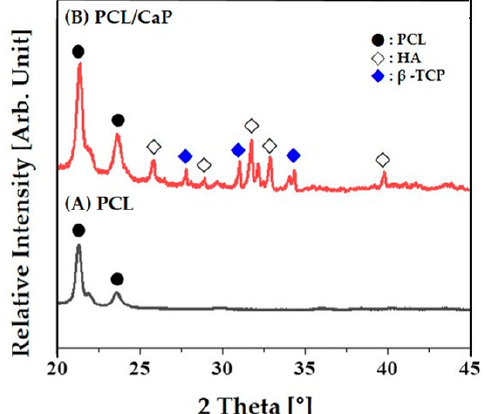
Figure 8. Representative XRD pattern of ( A ) the PCL and ( B ) PCL–CaP composite sca ff old produced using a CaP content of 20